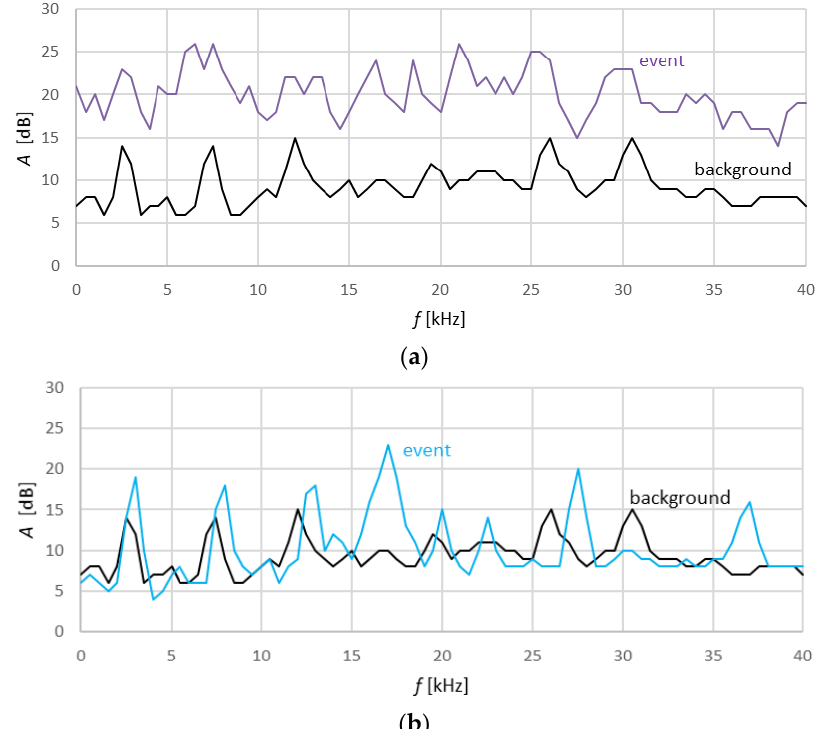
Figure 6. Exemplary specimens of fiber cement boards belonging to ( a ) series C air-dry and ( b ) series C stored in water for 24 h.